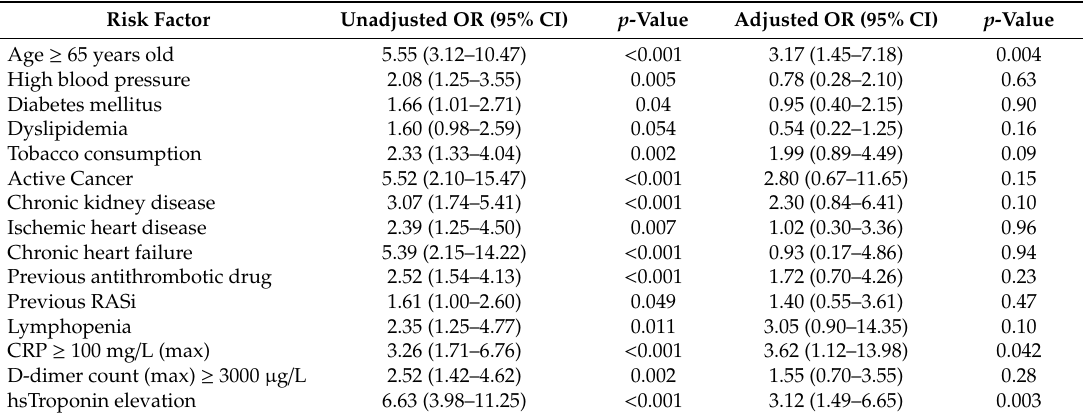
Table 2. Univariate and multivariate analysis of baseline risk factors for